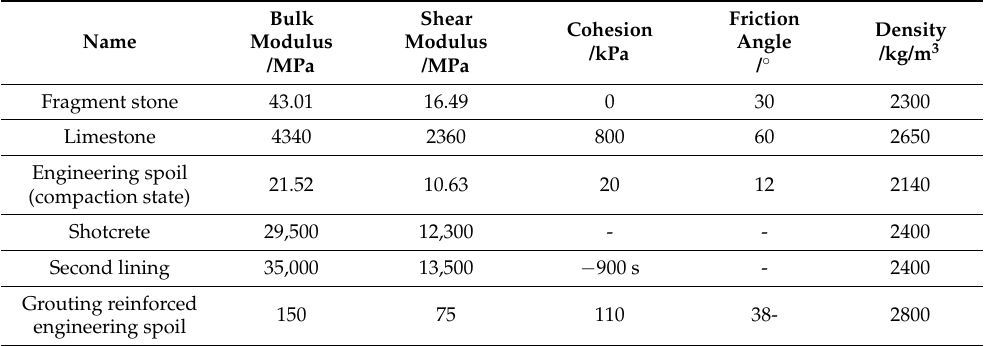
Table 1. The physical and mechanics parameters of stratum.